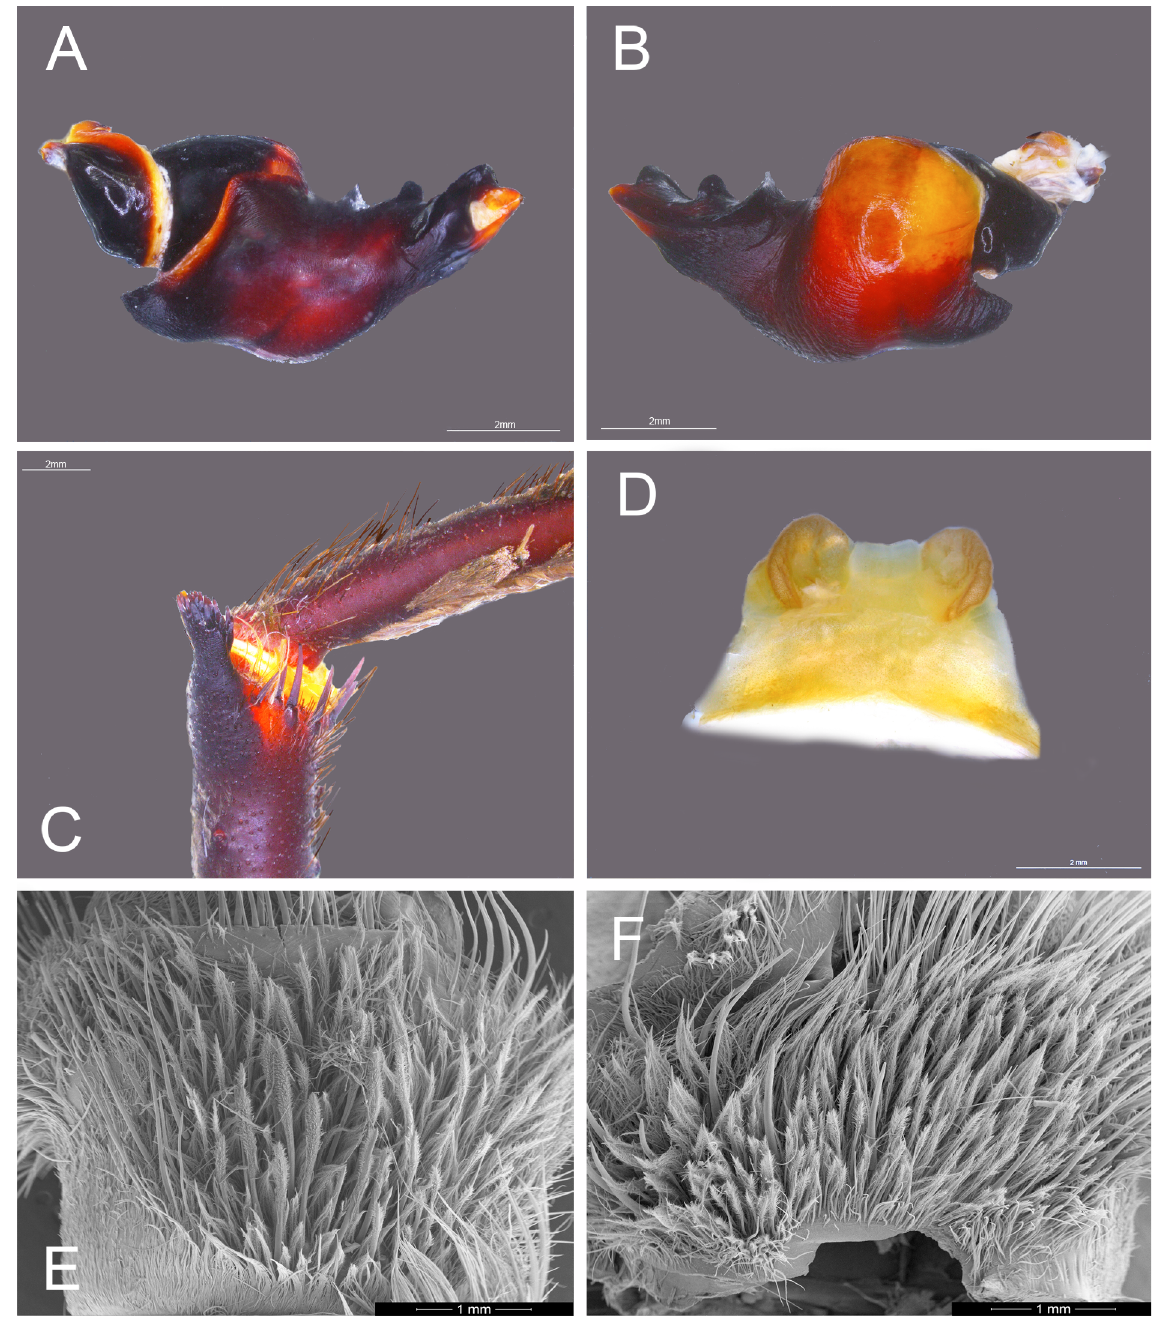
Fig. 1. Acanthoscurria geniculata Ausserer, 1871, ♂ and ♀, Santarém, Pará, Brazil (IBSP 151260). A–B . Palpal bulb. A . Retrolateral. B . Prolateral. C . Tibial apophysis, retrolateral. D . Spermathecae, dorsal. E . Male palp, trochanter, stridulatory organ. F . Trochanter I, stridulatory